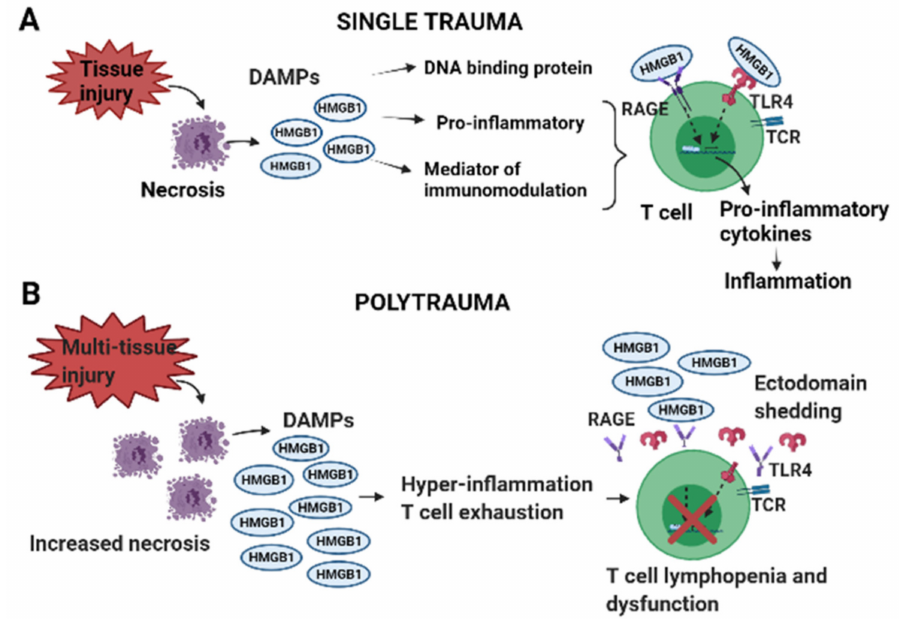
Figure 7. Graphical illustration showing the effects of high mobility group box protein 1(HMGB1), a damage-associated molecular pattern (DAMP) in ( A ) single trauma and ( B ) polytrauma (PT). Several DAMPs such as HMGB1, mitochondrial DNA (mtDNA), S100 and other similar molecules are released from the cytosol of necrotic cells following injury and the damage of the cell membranes. Despite the importance of all DAMPs in mounting inflammation, here we shed light on the role of HMGB1 in PT due to its prominence as an early post-traumatic predictor marker [14,15]. Following injury circulating levels of HMGB1 are relatively lower in a single injury than in PT. HMGB1 mediates pro-inflammatory and immunomodulatory responses by binding to receptor for advanced glycation end products (RAGE) and toll-like receptor 4 (TLR4) on immune cells and triggers pro-inflammatory cascades in the surrounding cells the host must compensate for to maintain homeostasis. However, while inflammation is vital for regulating tissue homeostasis and repair if overburdened by the early surge of HMGB1, it can result in hyper-inflammation and immune cell exhaustion causing T cells to alter their phenotypes and undergo ectodomain shedding of RAGE and TLR4, leading to T cell lymphopenia and